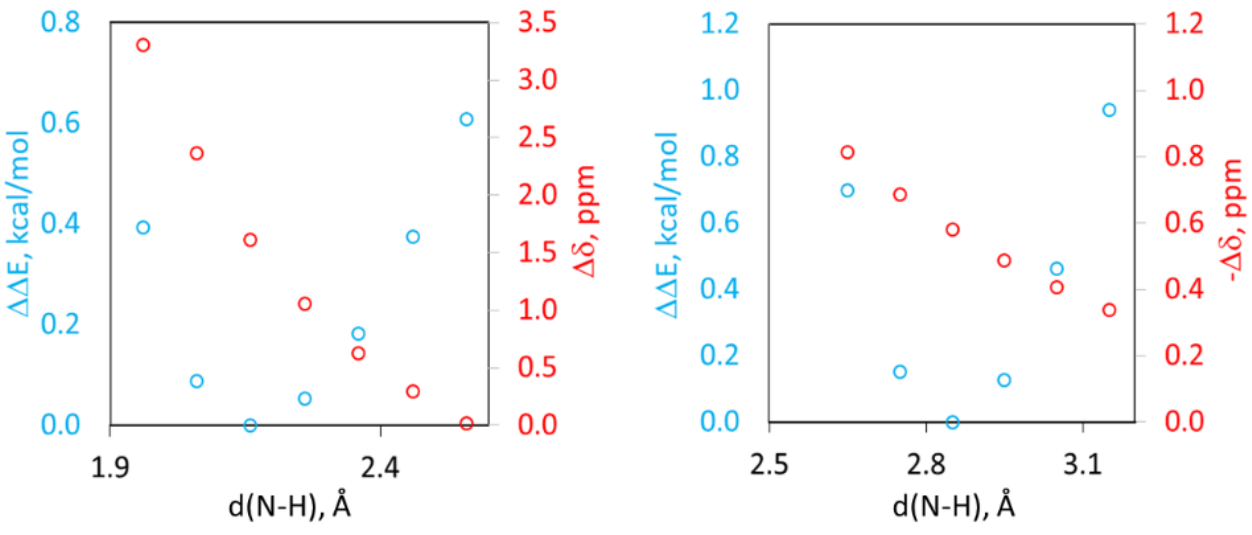
Figure 7. Dependencies of the energies (blue circles) of HB ( left ) and XB ( right ) complexes relative to that of the energy minimum and the chemical shifts in the proton (red circles) relative to that in the individual CHI 3 on interatomic separations.